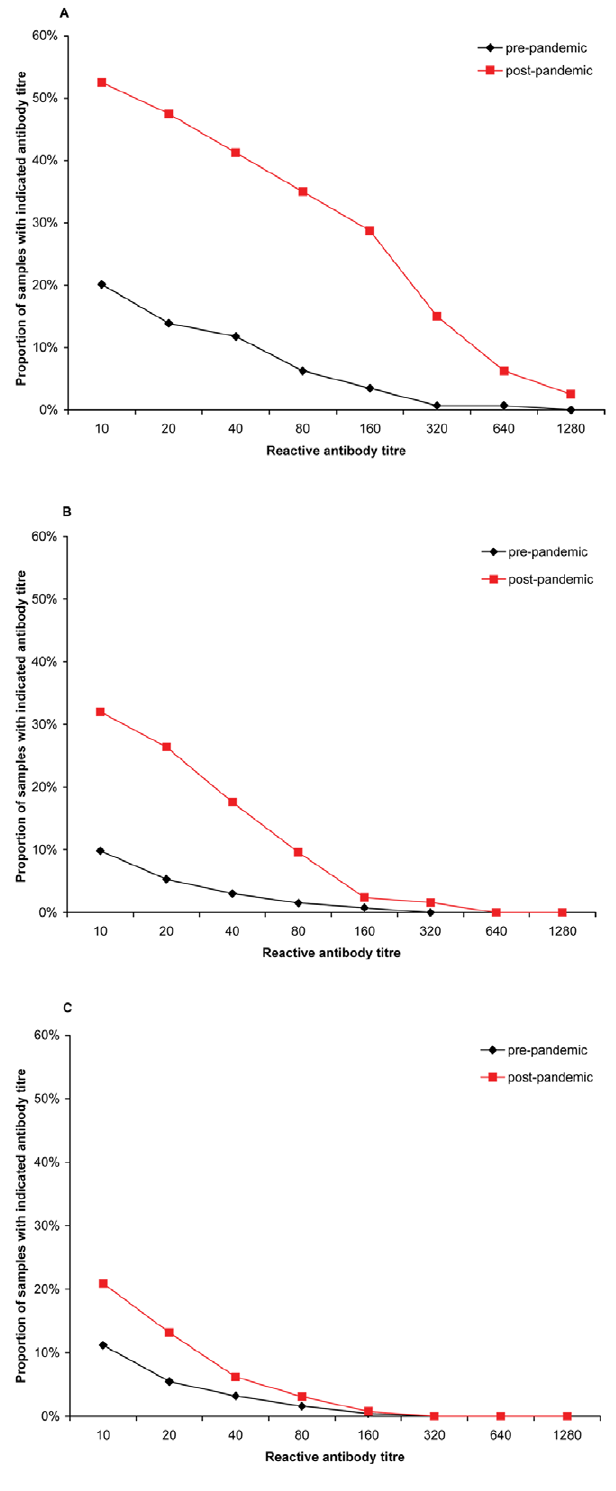
Figure 2. Reverse cumulative distribution curves by birth cohort. Reverse cumulative distribution curves for pre-pandemic and post-pandemic samples by birth cohorts A) after 1976 (18–32 years), B) between 1957 and 1976 (33–52 years), C) before 1957 ( $ 53 years) and measured antibody titres.